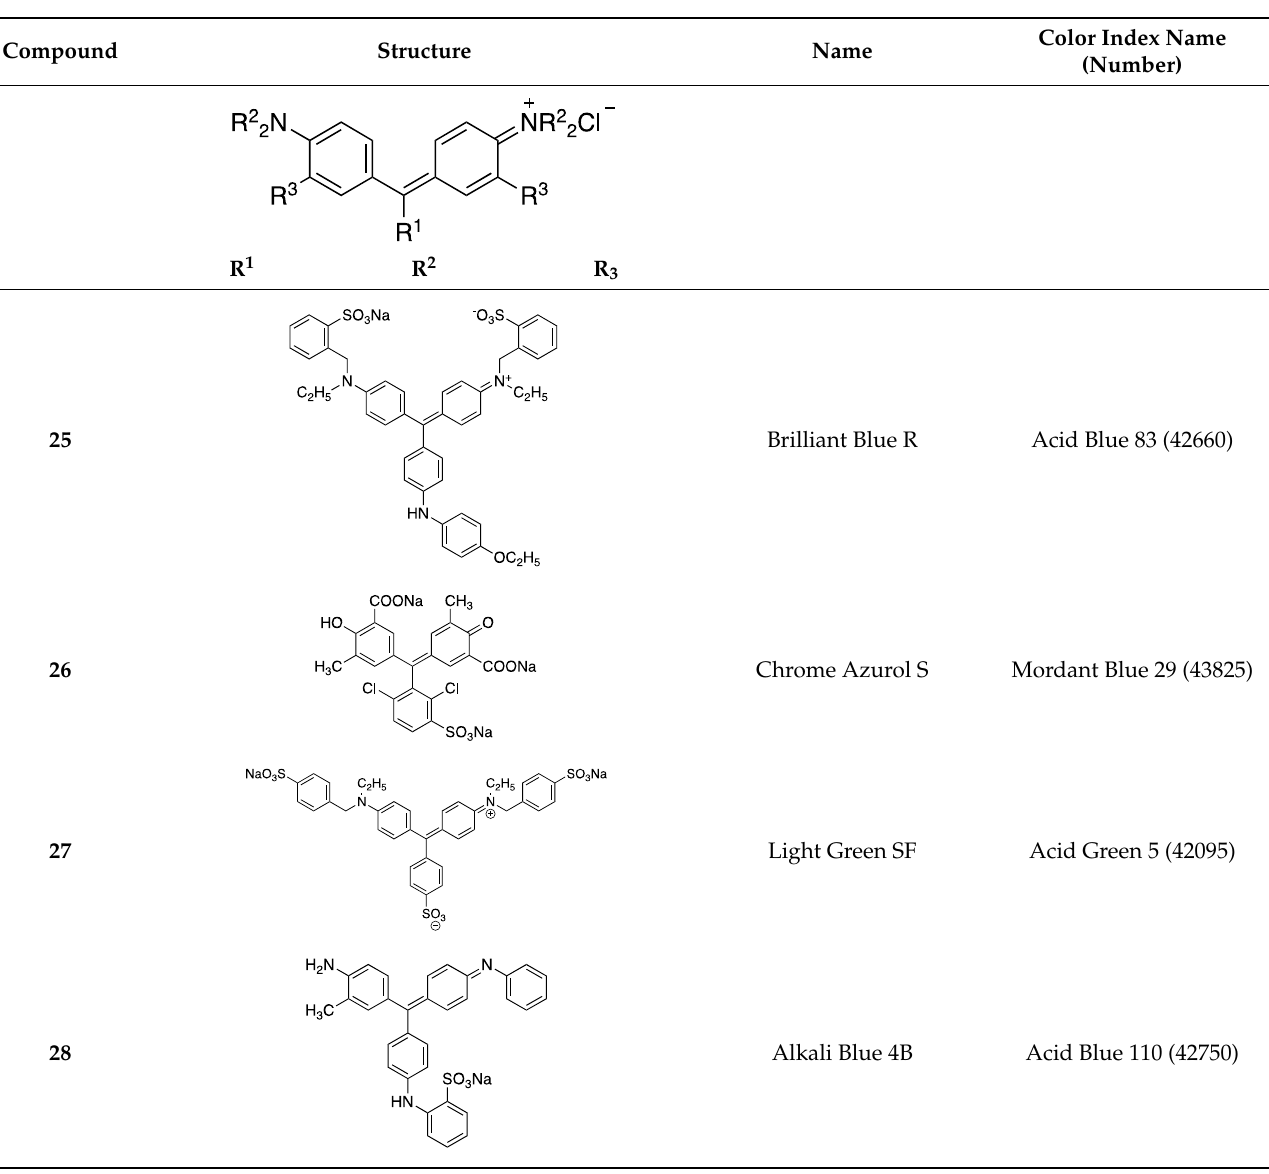
Table 3. Arylmethane textile dyes. Table 3. Cont.